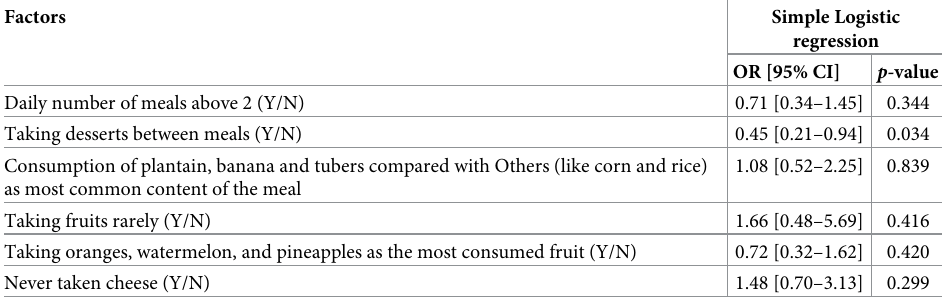
Table 6. Nutritional factors associated with ionised hypocalcaemia in pregnancy. Factors